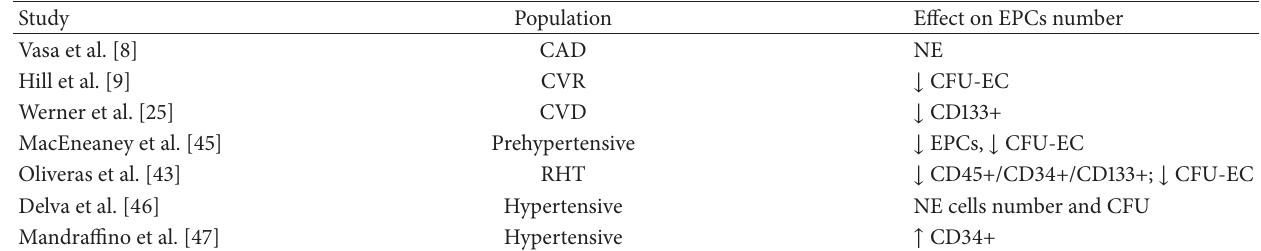
Table 2: Hypertension and